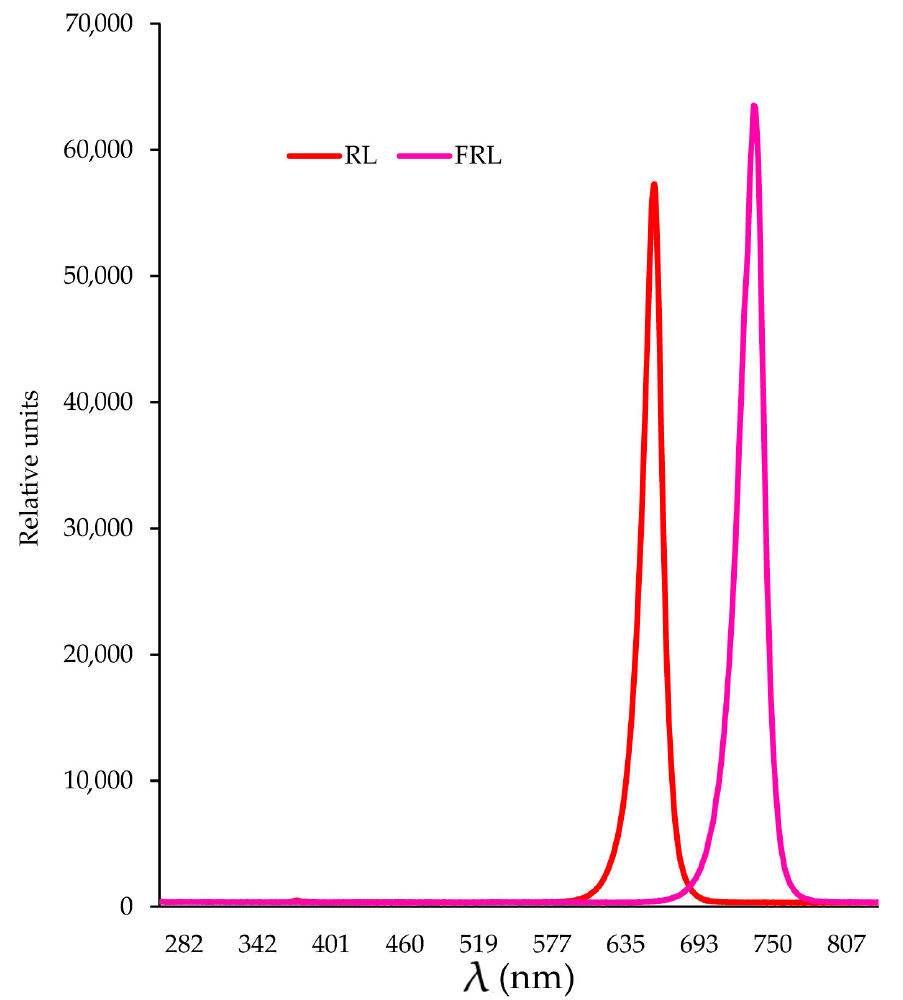
Figure 1. Emission spectra of the light sources used in the experiments.